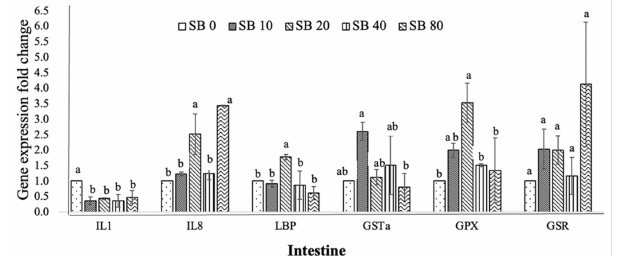
Figure 2. Expressions of immune (interleukin 1, IL1; interleukin 8, IL8; lipopolysaccharide binding protein, LBP) and antioxidant-related genes (glutathione S-transferase, GSTa; glutathione-disulfide reductase, GSR; glutathione peroxidase, GPX) in intestine of Nile tilapia after treated with phenol rich. Three replicates. a,b Columns without the same superscripts differ ( p <